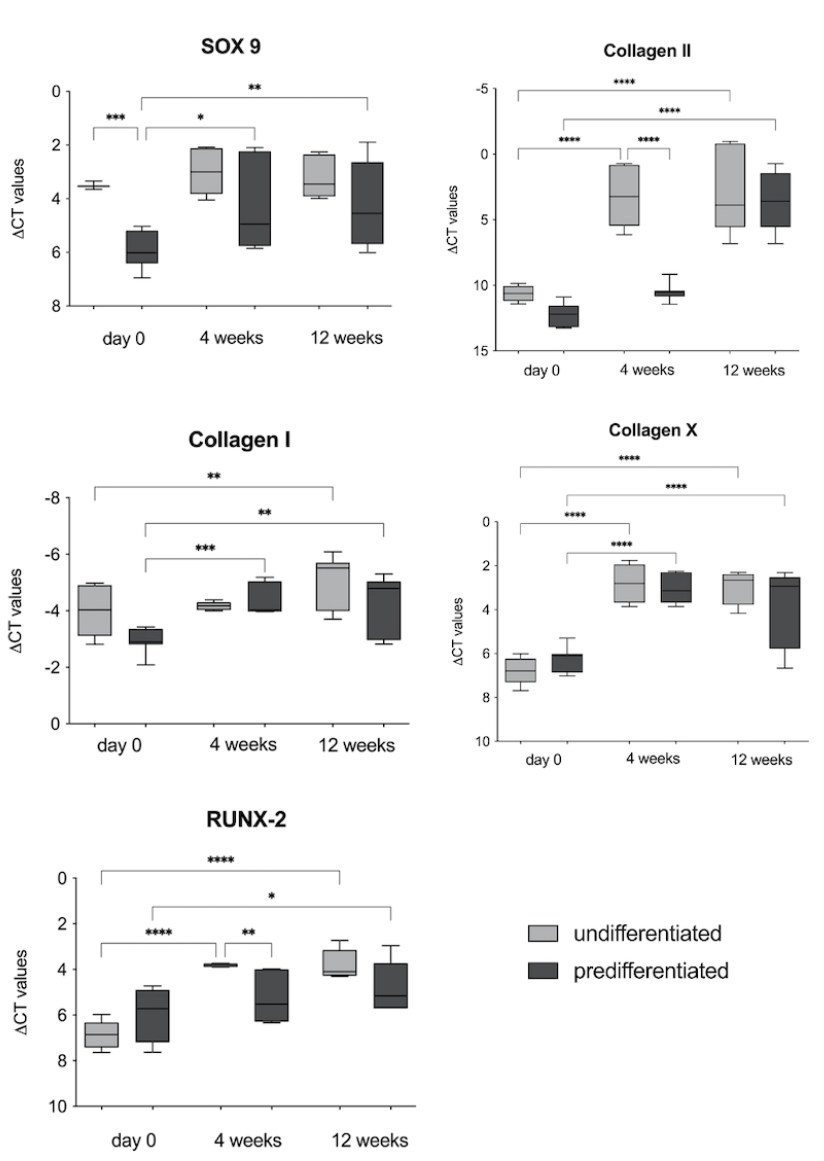
Figure 9. RT-PCR analysis of cell-seeded PU-fibrin composites in vivo (New Zealand White Rabbit): The gene expression of SOX-9; collagen I, II, and X; and RUNX-2 was analysed and presented as values ( ∆ CT values) normalised to the gene expression of the housekeeping gene GAPDH 4 weeks and 12 weeks after the implantation of the cell-seeded constructs. The chondrogenic marker genes SOX-9 and collagen II were elevated in both groups after 4 and 12 weeks. After implantation, the increase in SOX-9 expression compared to day 0 was only significant for the constructs predifferen- tiated with BMP-6 and TGF-ß3. Collagen II expression showed a significant increase at 4 and 12 weeks compared to day 0 in the undifferentiated group (EM-DMEM) and at 12 weeks in the predif- ferentiated group. The expression of the dedifferentiation markers collagen I and collagen X was significantly increased for both groups over the 12 weeks in vivo. RUNX-2, a transcription factor for osteogenic differentiation, was also significantly expressed by both groups during the time course compared to day 0. Box-Whisker plots show the median, 1st quartile, 3rd quartile, and the minimum